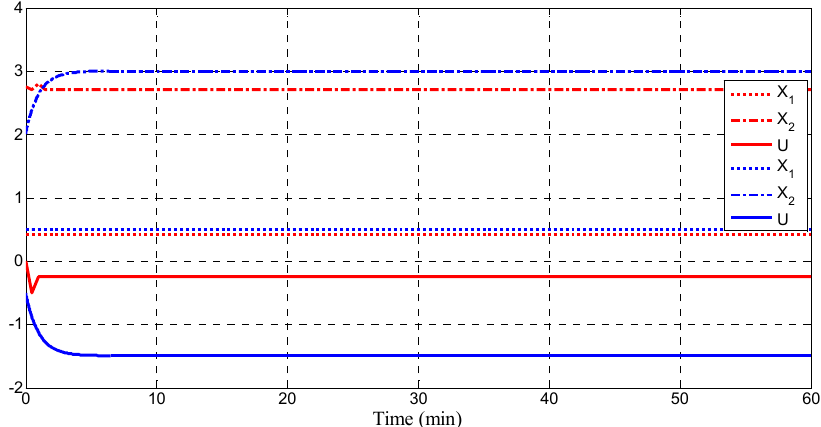
Figure 8. SMC and I/O FBL for D 2 = 0.02, ρ = 1, ϑ = 0.5, (blue) and D 2 = 0.01, ρ = 1, ϑ = 0.5, (red).